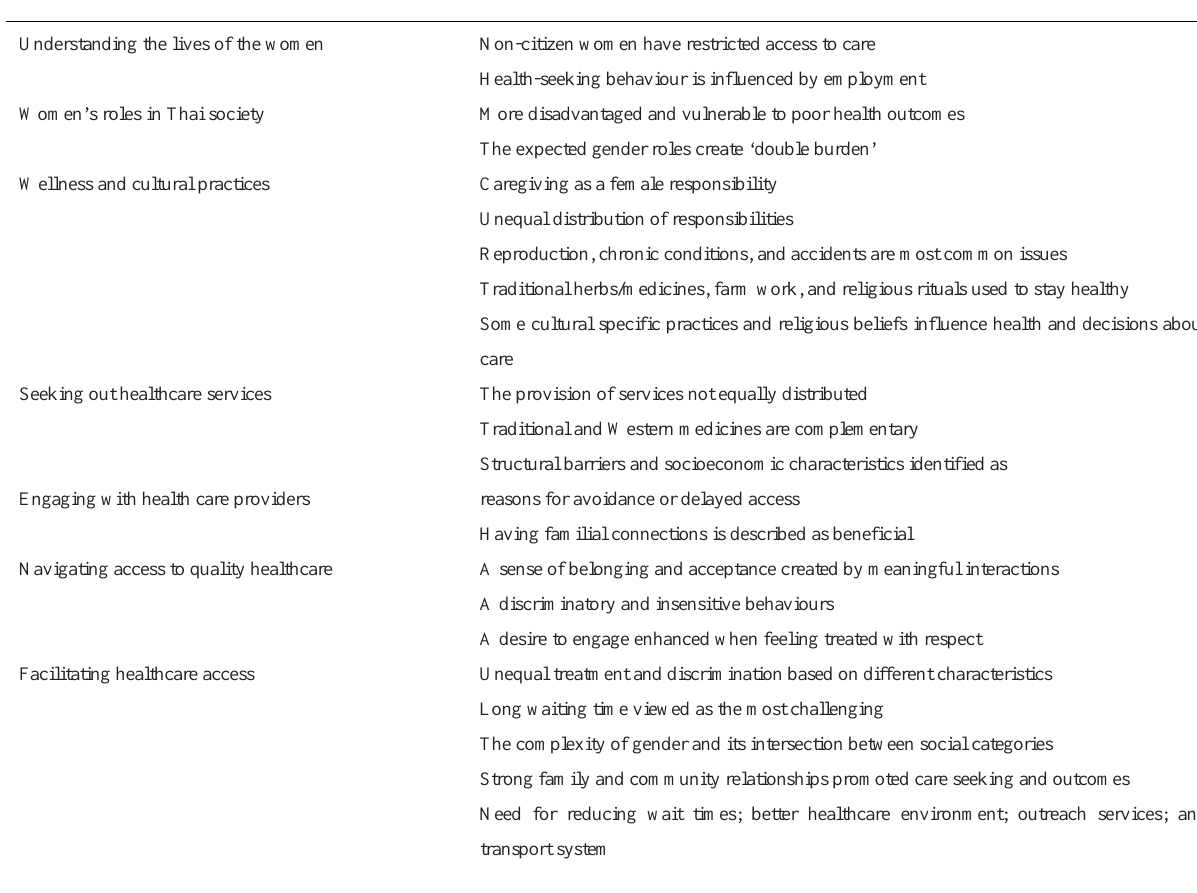
Table 2: List of Themes and Their Definitions during the operating hours.” I did not want to go there again and would rather treat my son’s symptoms myself” (Participant 17). Another undocumented participant stated, “I do not have citizenship… I am stuck here, I cannot go anywhere I want to” (Participant 16). intersecting influences affecting participants’ access to healthcare were identified throughout the interviews. These included specific transportation and distance challenges due to the rural and mountainous geography, contending with time away from work, long wait times, financial constraints, family responsibilities, severity of symptoms, and cultural discrimination. One participant shared, “I could spend a day waiting to see a doctor. It’s a waste of time. I